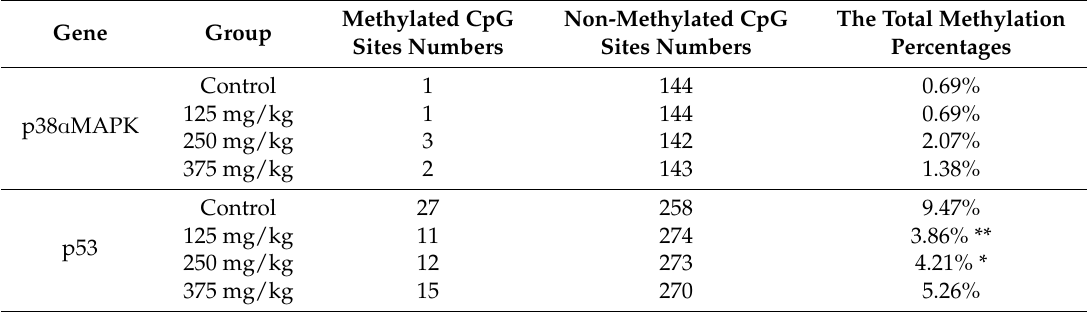
Table 2. Effect of DEHP exposure on p38 A MAPK and p53 gene promoter region methylation levels in the liver of mice ( n =